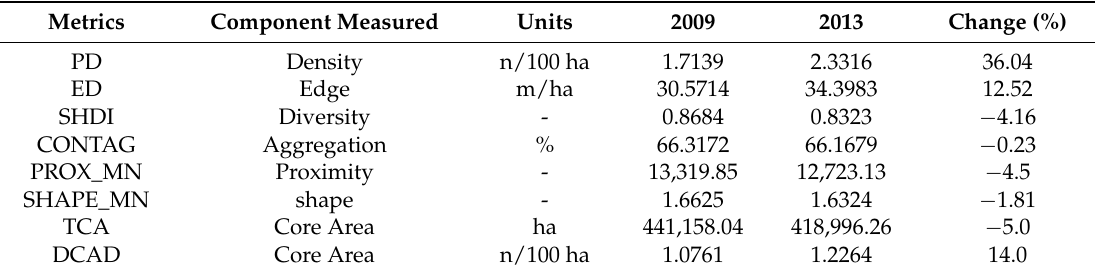
Table 3. Metrics at the landscape level in Lijiang River Basin between 2009 and 2013 (PD = patch